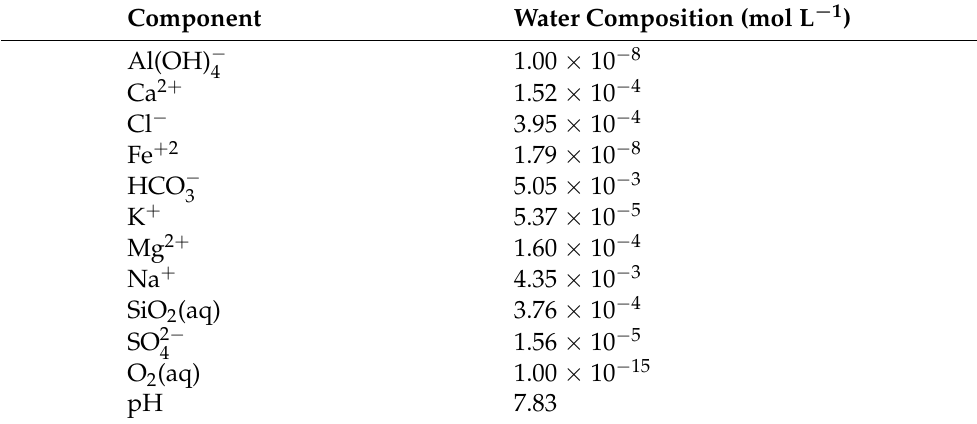
Table 8. Initial porewater composition used in the sensitivity analysis.